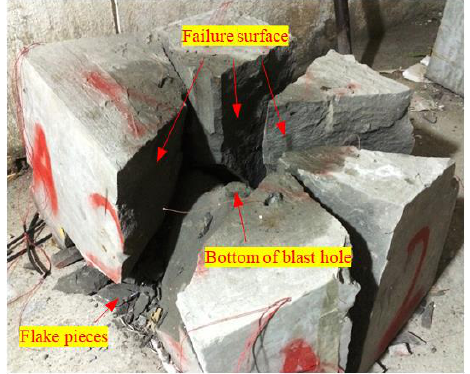
Figure 9. Conical and flaky masses formed after blasting of specimen A2.